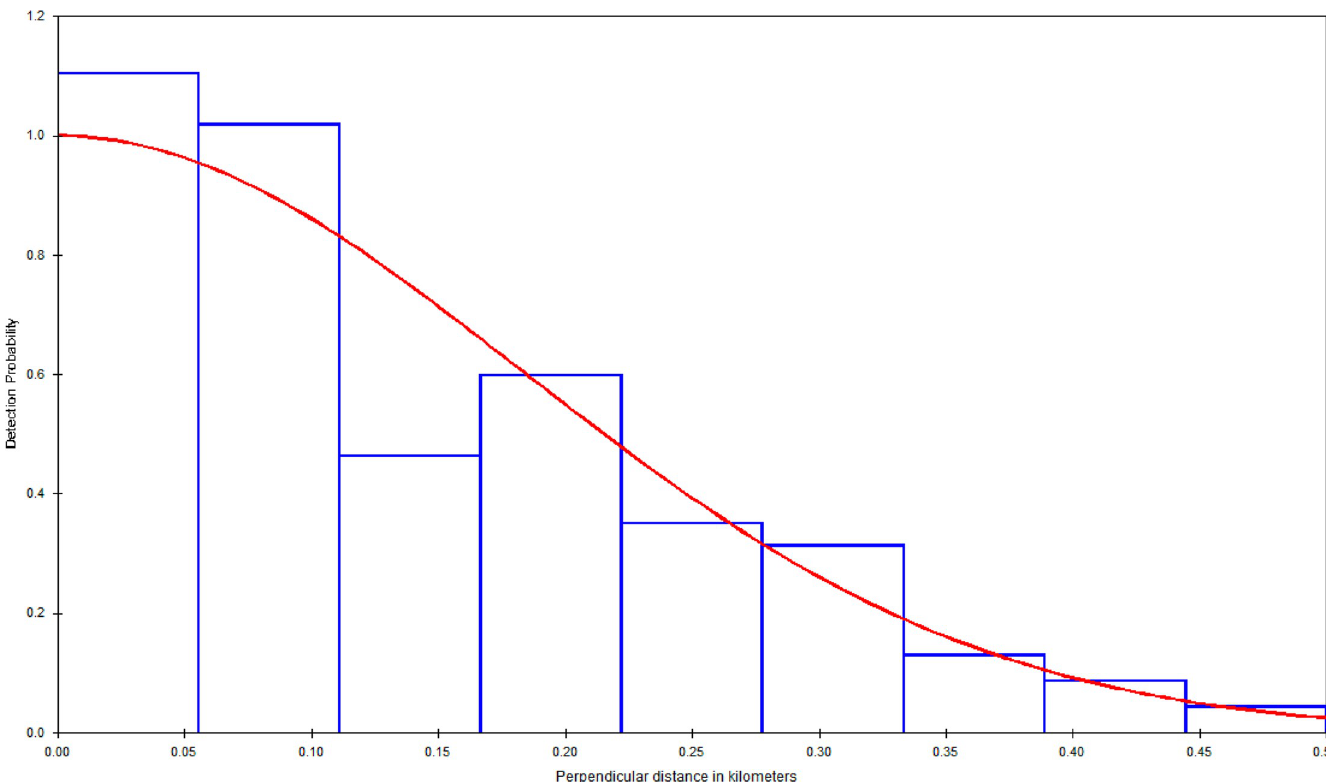
Fig 4. Perpendicular sighting distance histogram and fitted detection function (using a Half-Normal model with cosine adjustment), Southern Puget Sound.